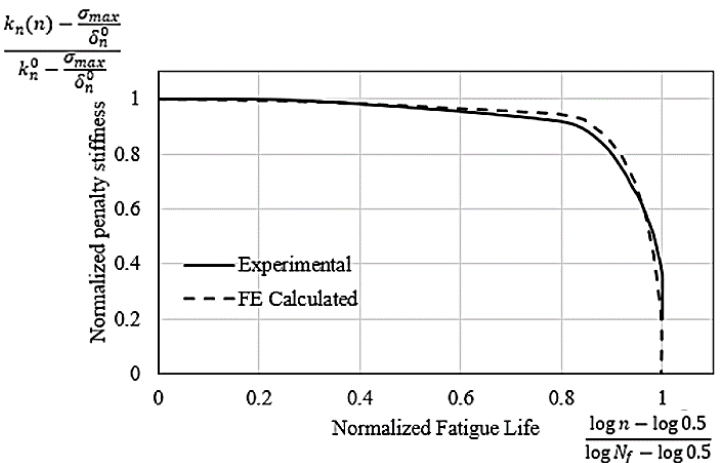
Figure 12. Interface normalized penalty stiffness and normalized fatigue life for experimental and FE-calculated results.